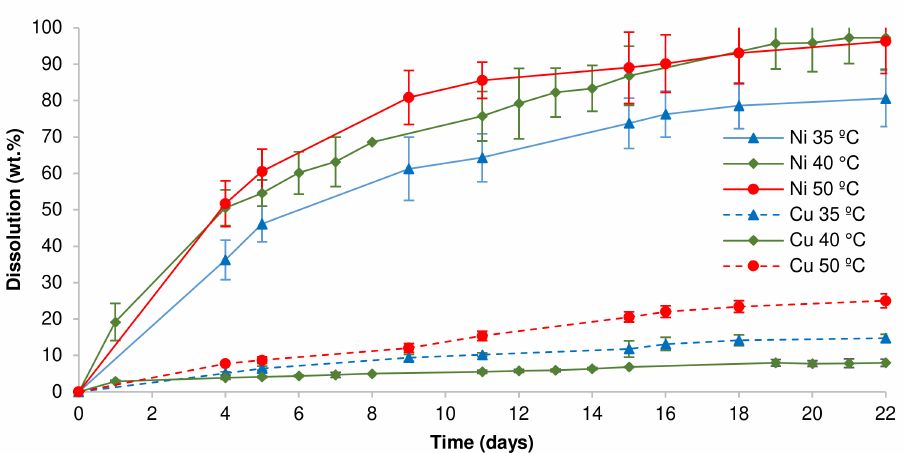
Figure 3. Rate of copper and nickel dissolution during stirred-tank bioleaching (pulp density, 1